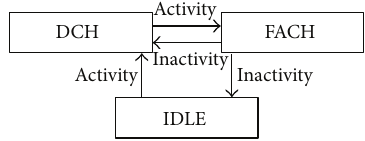
Figure 3: Simplified Radio Resource Control state